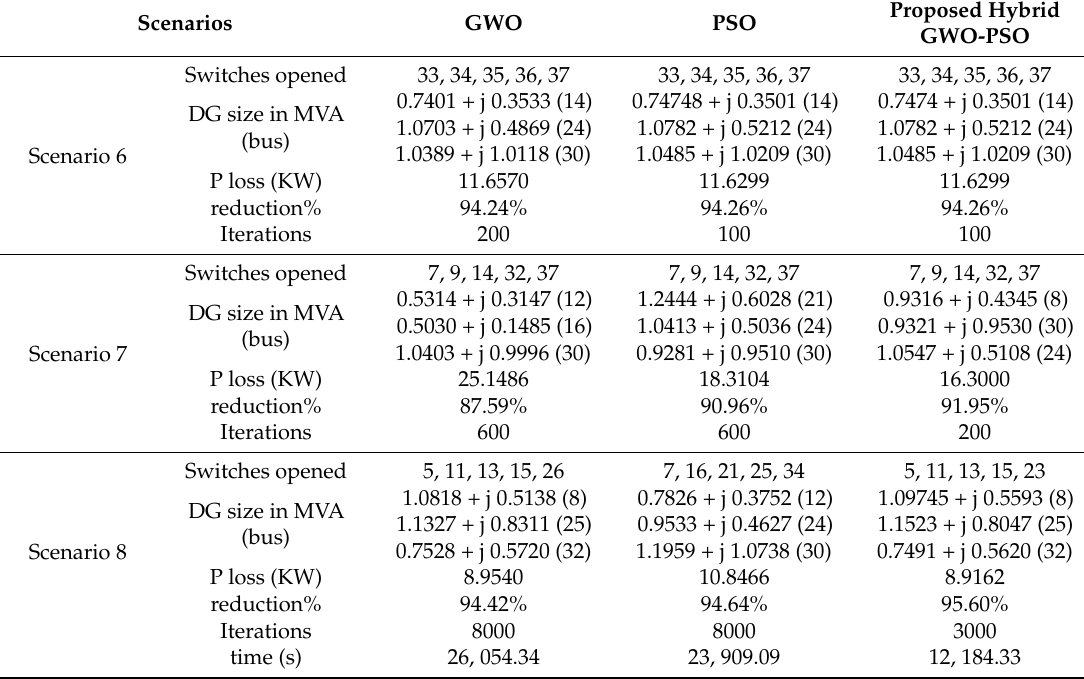
Table 3. Comparison of simulation results for PQ+-type DG units of a 33-bus